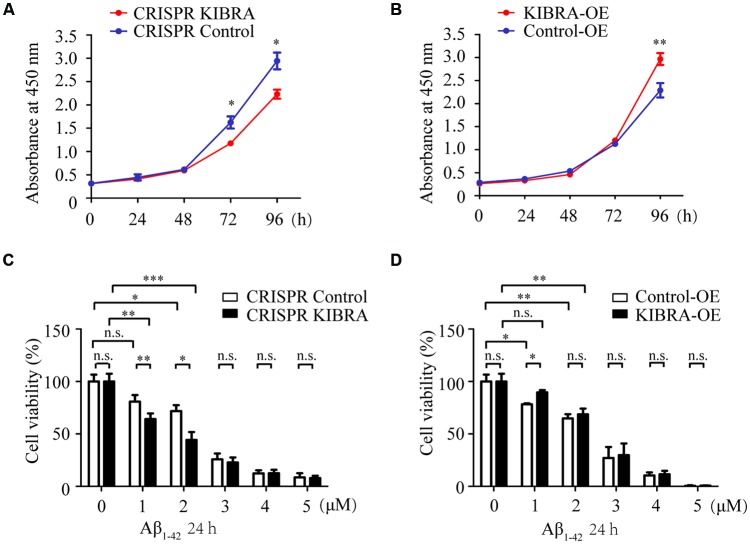
The indispensable role of KIBRA against Aβ1–42 oligomers-induced neurotoxicity. Cell proliferation was assessed by CCK8 assay in KIBRA cell lines. The results showed that KIBRA knockdown (A) significantly suppressed cell growth at 72 h and 96 h after seeding, whereas overexpression of KIBRA (B) started to stimulate cell proliferation at 96 h. CCK8 assay was also carried out with various doses of Aβ1–42 oligomers (0, 1, 2, 3, 4, and 5 μM) and Aβ1–42 oligomers induced the decrease of cell viability in a dose-manner (C,D). Interestingly, the CRISPR KIBRA cells were more sensitive to the toxicity of Aβ1–42 oligomers than the CRISPR control cells (C). Overexpression of KIBRA significantly promoted cell viability compared to the control group (D). Results are means ± SEM (n = 4 per group) from independent experiments. *p < 0.05, **p < 0.01 and ***p < 0.001, n.s., not significant (p > 0.05).